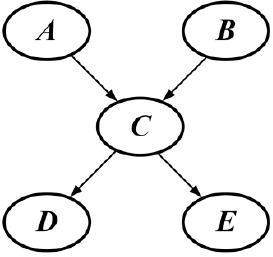
Figure 3. Basic BN.